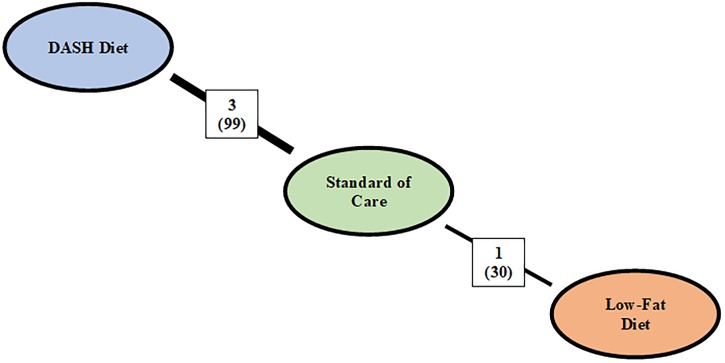
Network plot of trials that reported fasting glucose and did not provide gestational weight gain advice in both dietary arms.Abbreviations: DASH, Dietary Approach to Stop Hypertension. The colors of each nodep correspond to a different diet class: orange node represents diets that targeted macronutrient composition, blue represents diets that targeted food consumption, and green on weight gain advice. The number above each line correspond to the number of trials that compared the two diets with the number of included participants expressed in brackets.